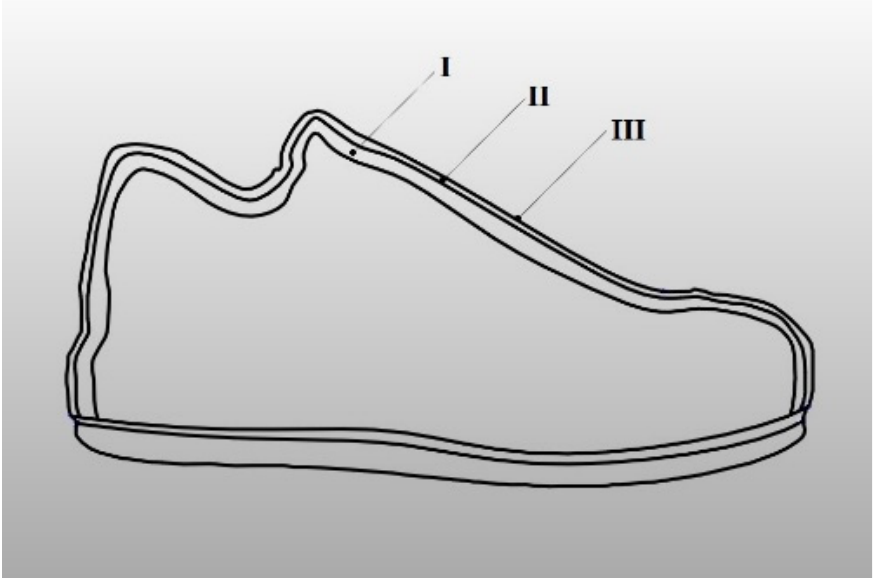
Figure 1. A schematic cross-section of footwear with marked layers (I—polyester spacer knitted